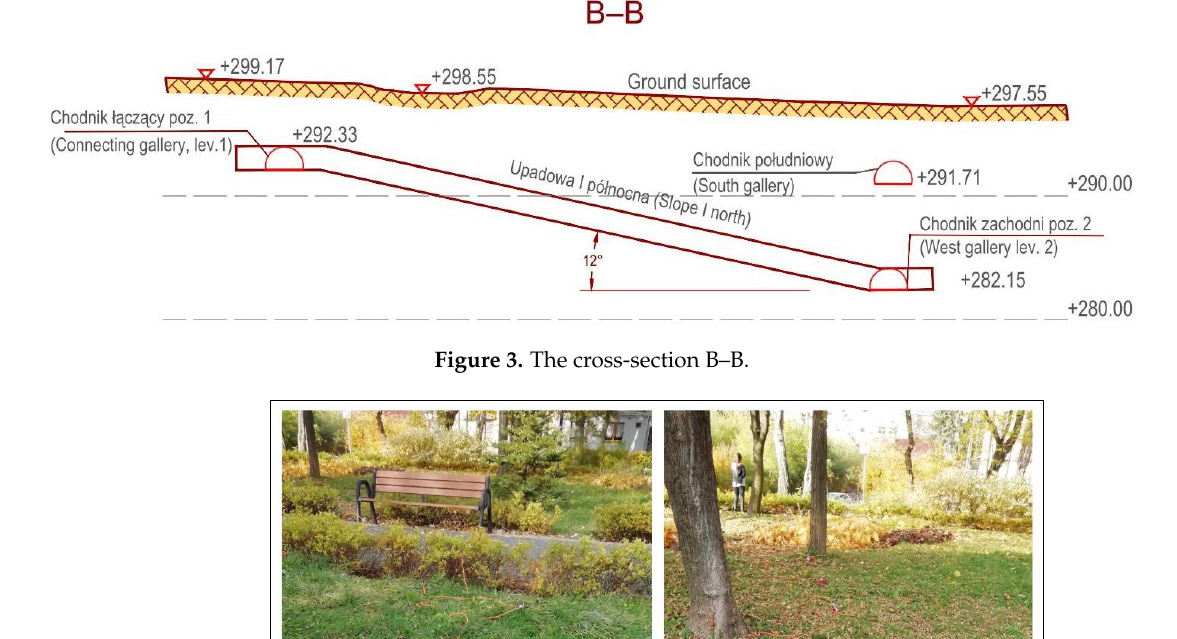
Figure 4. The general look over the area of study.